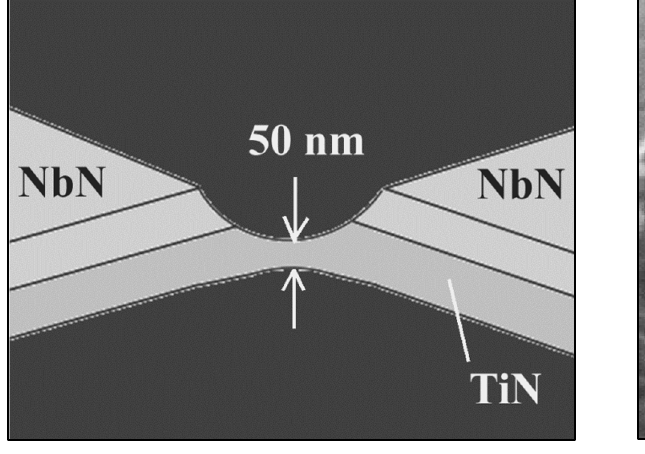
Figure 1. Schematic diagram of a 4 nJJ nanoSQUID with 3 current leads. Josephson junctions with larger critical currents I c 2 and smaller phase drops ϕ 2 < π /2 are shown by larger crosses.